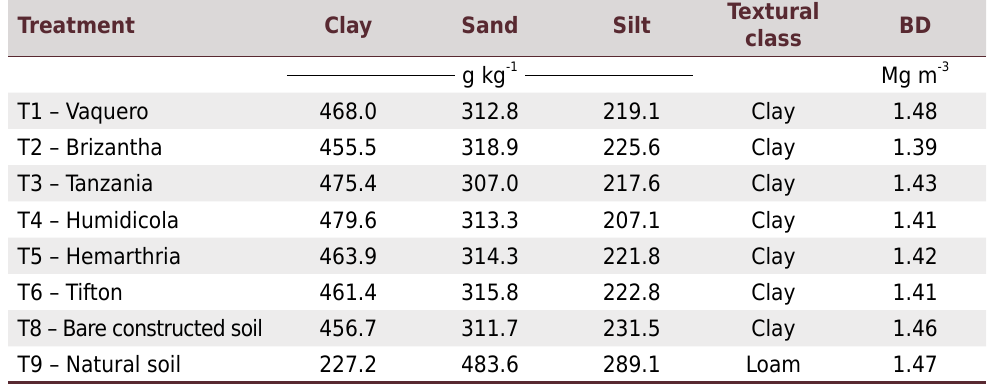
Table 1. Particle size distribution, textural class and bulk density (BD) in the 0.00-0.05 m layer of a constructed soil covered with different grass species, a bare constructed soil and a natural soil (unmined, with native vegetation) Treatment Clay Sand Silt